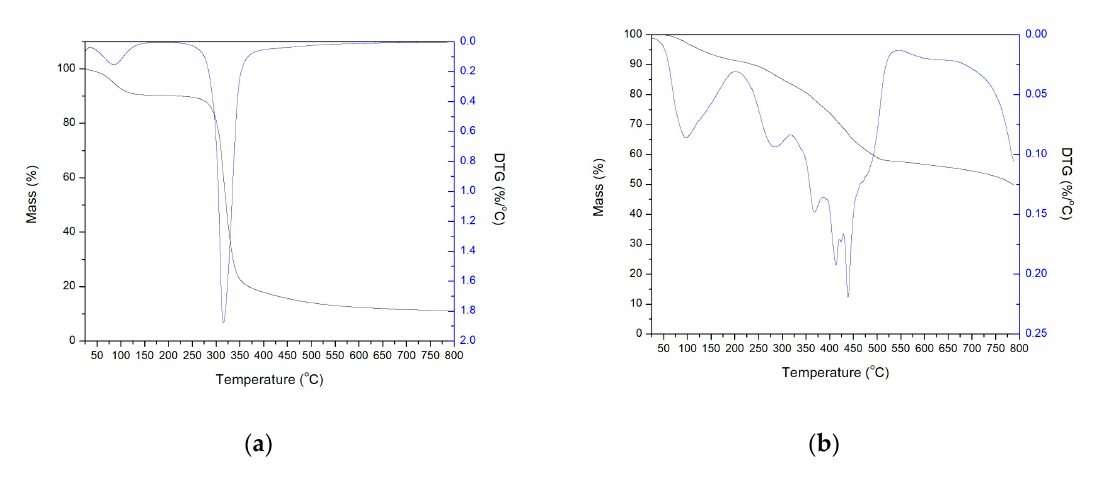
Figure 2. TG and DTG curves: ( a ) babassu mesocarp and ( b ) lyophilized hydrogel of the mesocarp reticulated with acrylamide with fertilizer added.